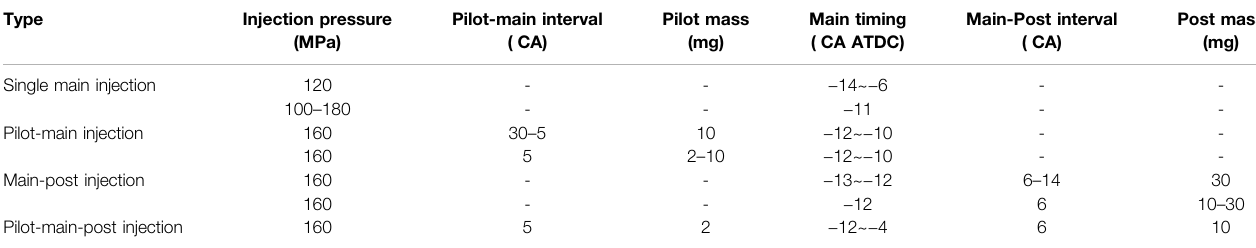
TABLE 3 | Injection settings.